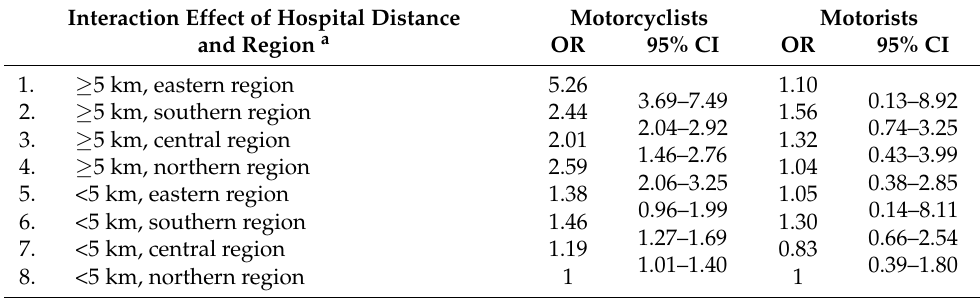
Table 5. Interaction of distance from the nearest trauma centre with trauma centre